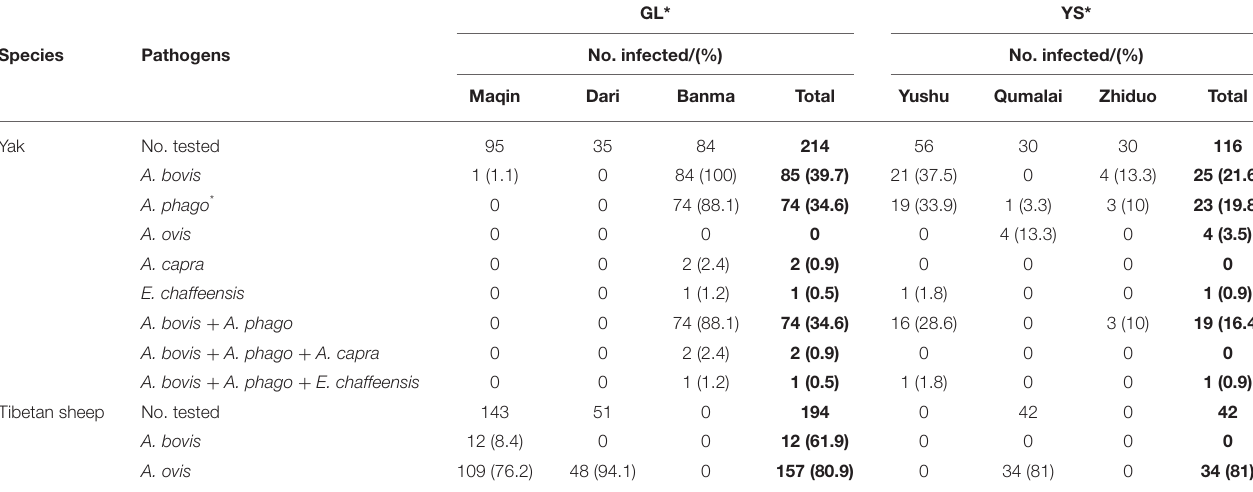
TABLE 2 | The prevalence of Anaplasma spp. and E. chaffeensis in Tibetan sheep and yaks in Qinghai, China.